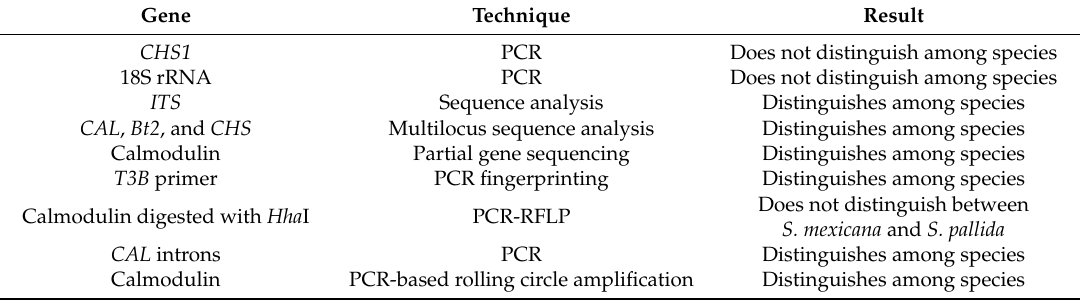
Table 1. Several molecular studies for Sporothrix species